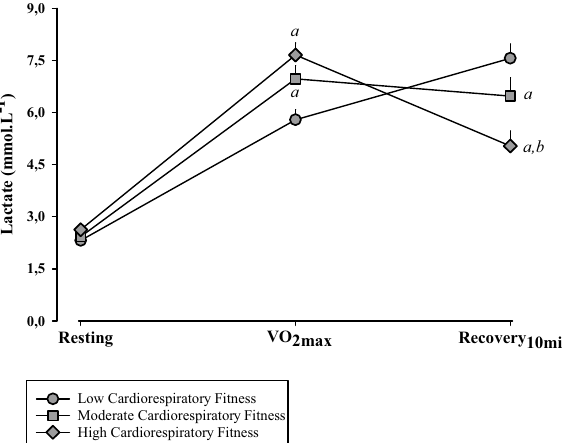
Figure 1. Peripheral blood lactate obtained during the maximal cardiopulmonary test at three different moments: resting; VO 2max ; and 10 min after the start of recovery (Recovery 10 min); mmol L −1 , millimol per liter; a P < 0.05 vs. Low Cardiorespiratory Fitness group; b P < 0.05 vs. Moderate Cardiorespiratory Fitness group.